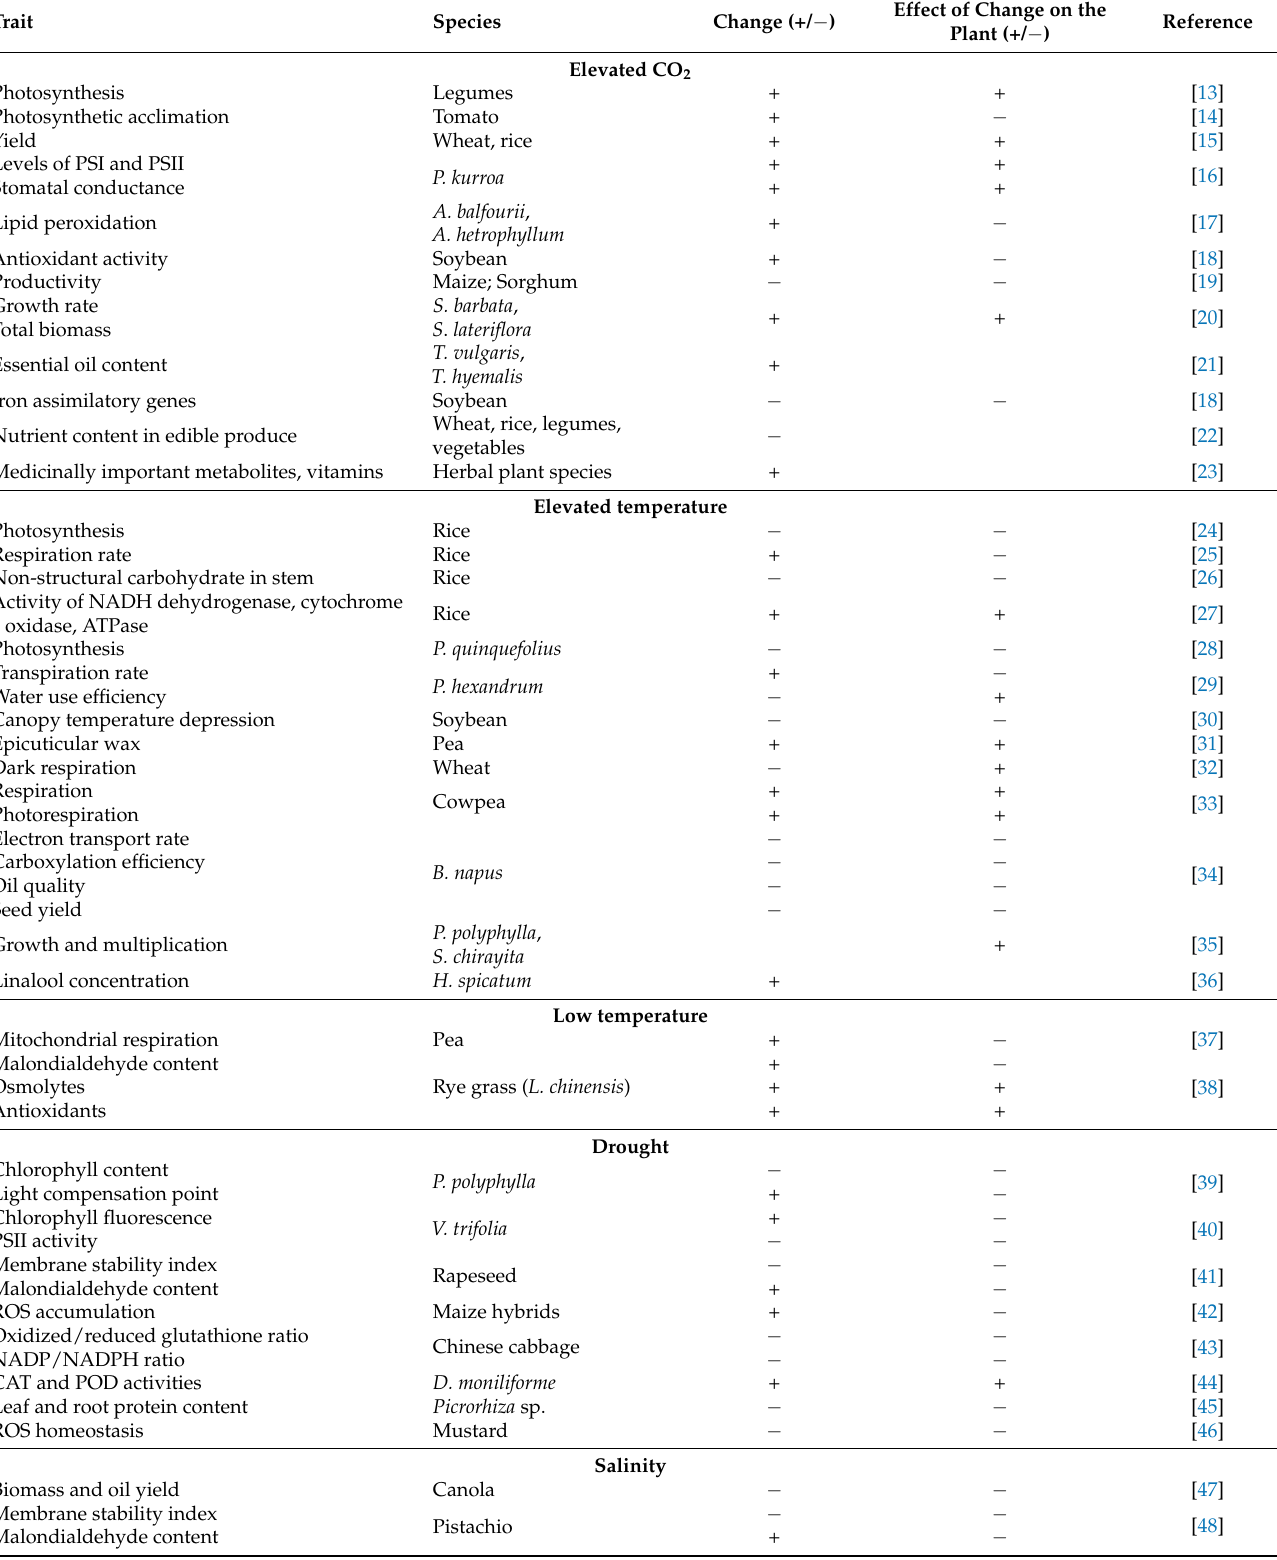
Table 1. The effect of various environmental conditions on physiological and biochemical attributes at cellular and plant levels determines tolerance or